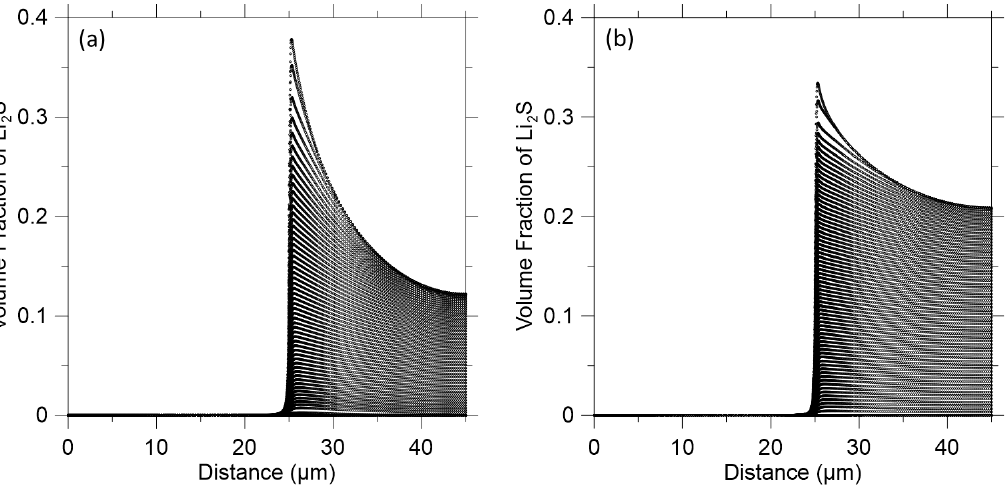
Figure 6. Lithium polysulfide volume fraction on the cathode: ( a ) Without the polymer composite layer; ( b ) With the polymer composite layer.